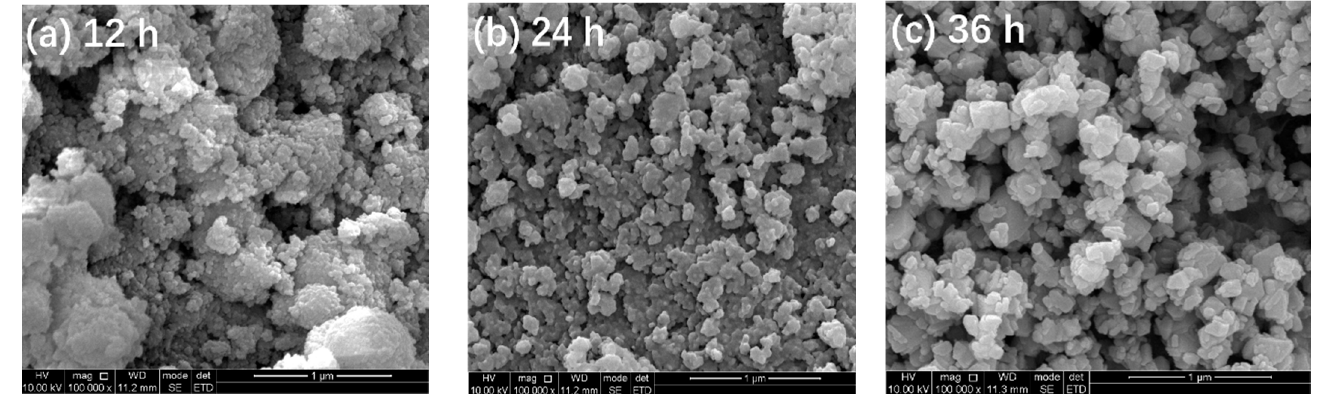
Figure 2. SEM images of TiO 2 -12 h ( a ), TiO 2 -24 h ( b ) and TiO 2 -36 h ( c